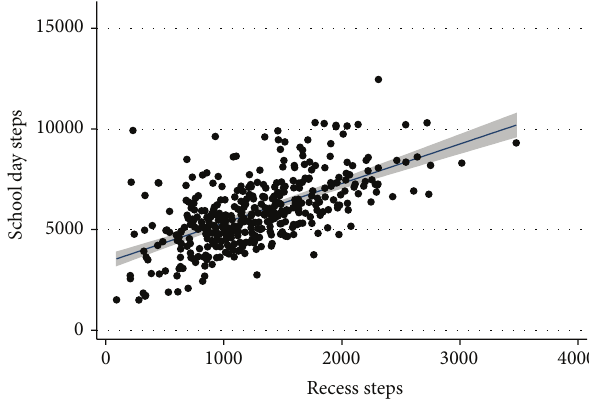
Figure 1: Scatterplot and line of best fit showing the linear rela- tionship between afternoon recess steps and school steps ( 𝑟 = 0.61 ; 𝑃 < 0.001 ).